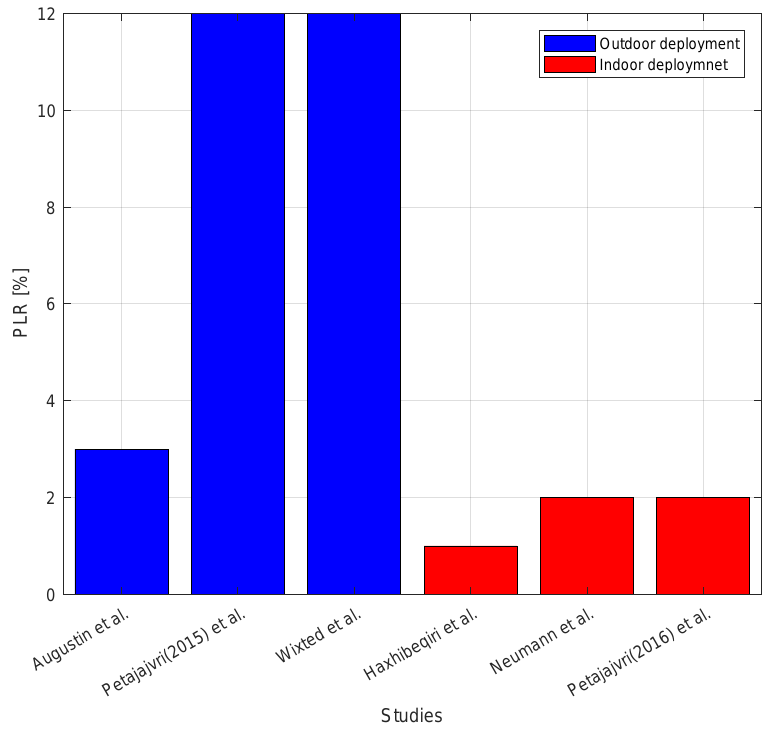
Figure 6. Packet loss ratio for different coverage test using SF12. Distanc from gateway was ~2 km for outdoor measurements and ~60 m for indoor